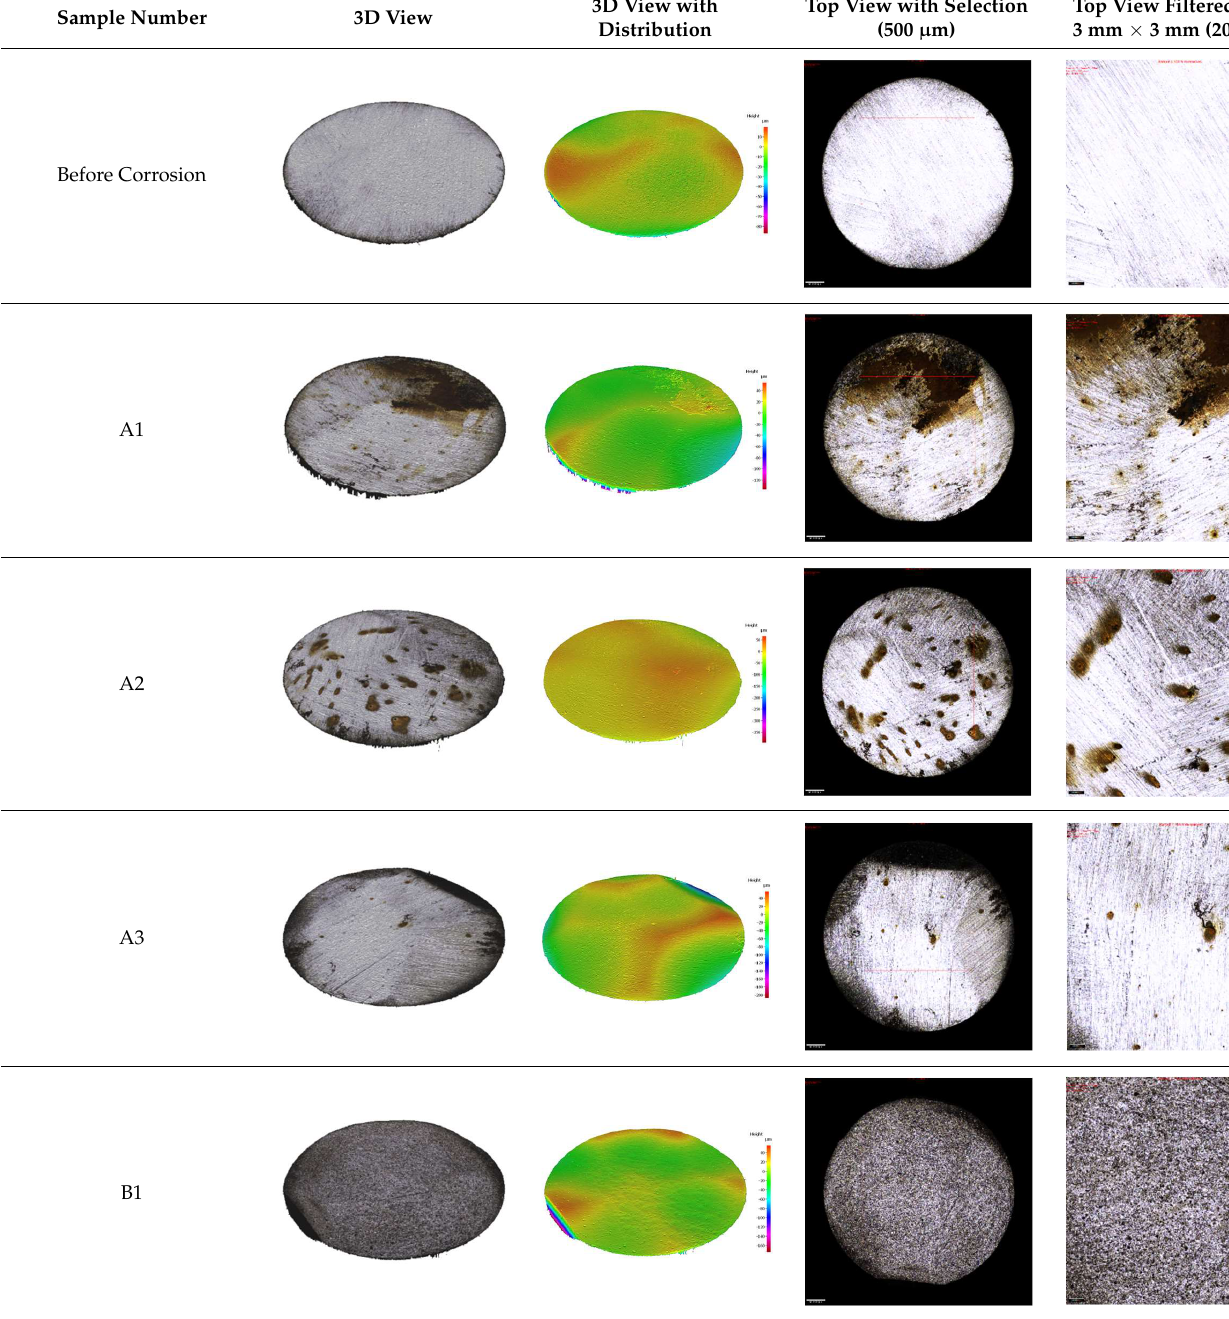
Table 4. Surface roughness at 5 × magnification using Alicona InfiniteFocus. Table 4 . Surface roughness at 5X magnification using Alicona InfiniteFocus . Table 4 . Surface roughness at 5X magnification using Alicona InfiniteFocus . Table 4 . Surface roughness at 5X magnification using Alicona InfiniteFocus . Table 4 . Surface roughness at 5X magnification using Alicona InfiniteFocus . Table 4 . Surface roughness at 5X magnification using Alicona InfiniteFocus . Table 4 . Surface roughness at 5X magnification using Alicona InfiniteFocus . Table 4 . Surface roughness at 5X magnification using Alicona InfiniteFocus . Table 4 . Surface roughness at 5X magnification using Alicona InfiniteFocus